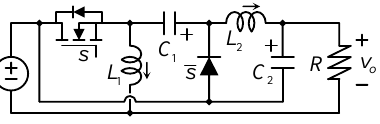
Figure 7. The proposed improved super-boost ISB converter.